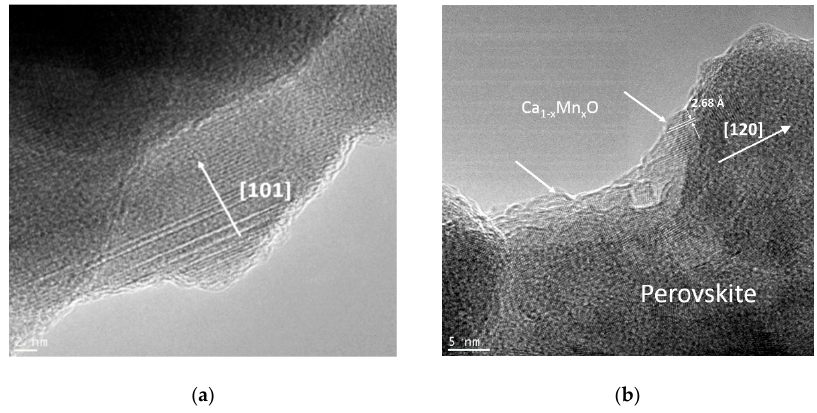
Figure 5. HRTEM images of perovskite particle after participation in methane oxidation reaction with planar defects ( a ) and Ca 1 − x Mn x O aggregates on the perovskite surface ( b ). It is possible that the appearance of Ca-Mn-O particles on the surface of the perovskite phase is due to the lower oxygen content in the gas phase. Moreover, the reduction of the sample is the cause of the observed slight decrease in catalytic activity during the catalytic tests.